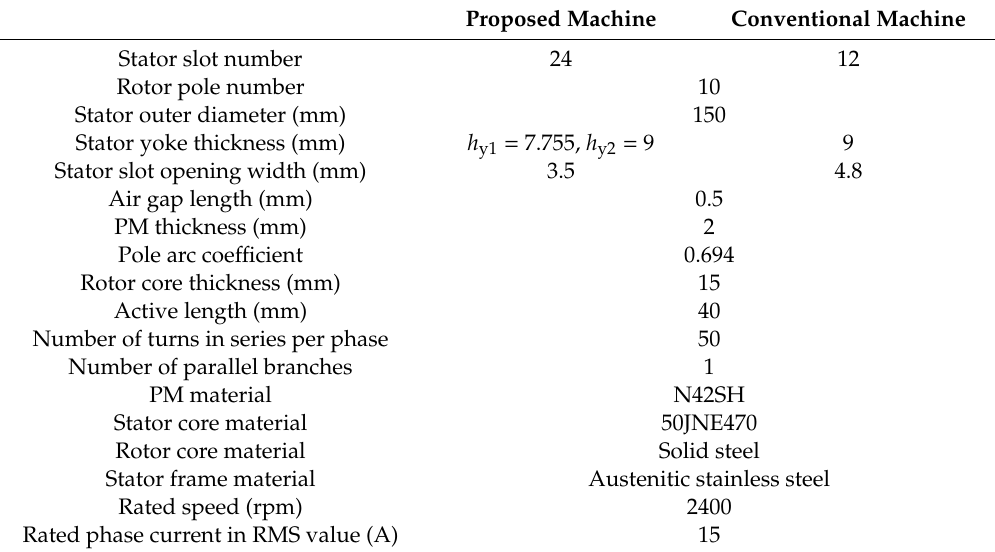
Table 3. Key parameters of the two compared